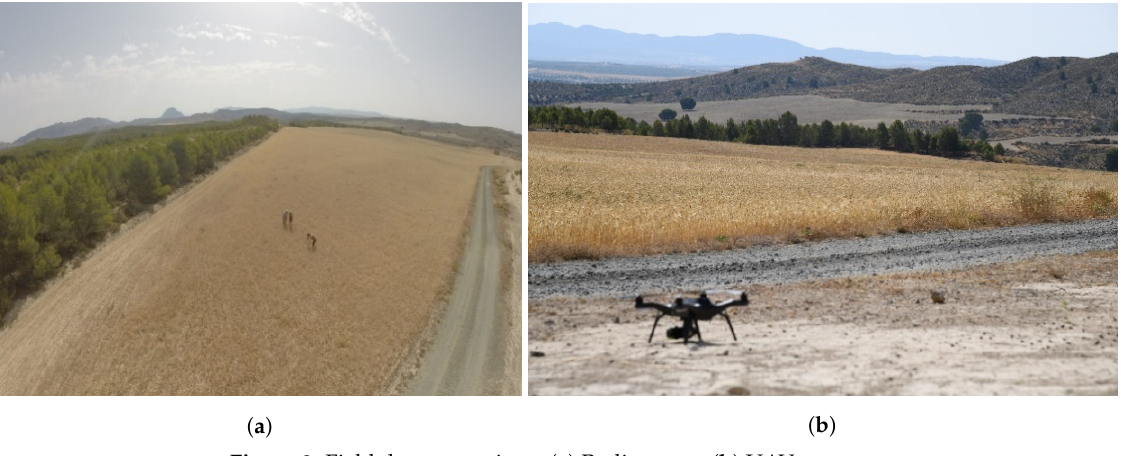
Figure 3. Field data campaigns. ( a ) Radiometry. ( b )